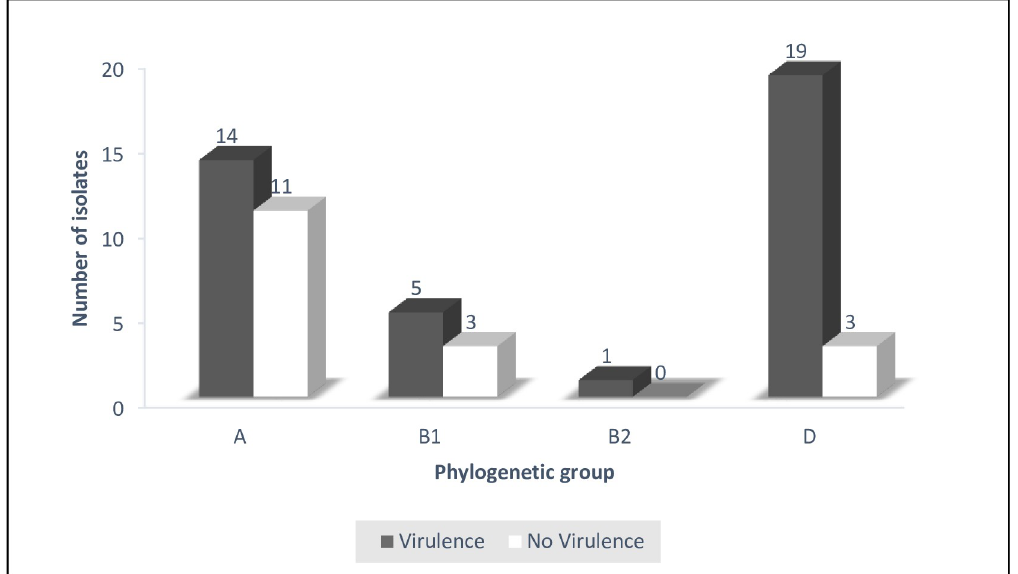
Fig 2. Virulence gene content of APEC isolates within each phylogenetic group. The dark bars indicate the proportion of APEC isolates within a phylogenetic group that had virulence genes while the white ones indicate those without virulence